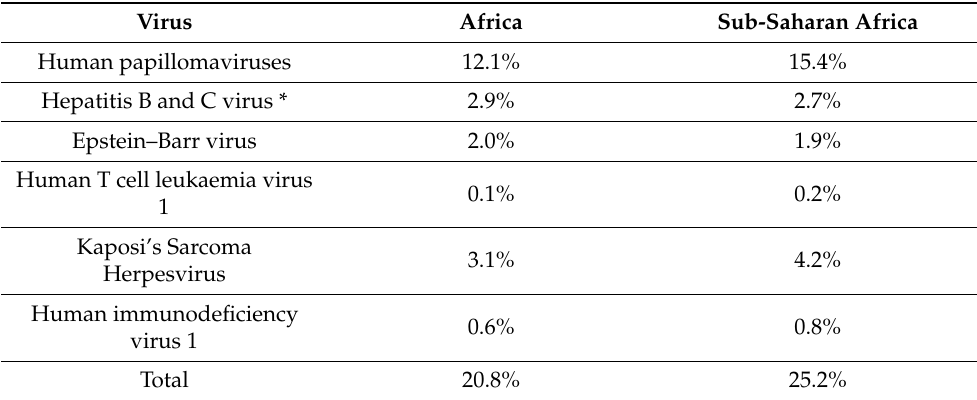
Table 2. Virally-Induced Cancers in Africa and Sub-Saharan